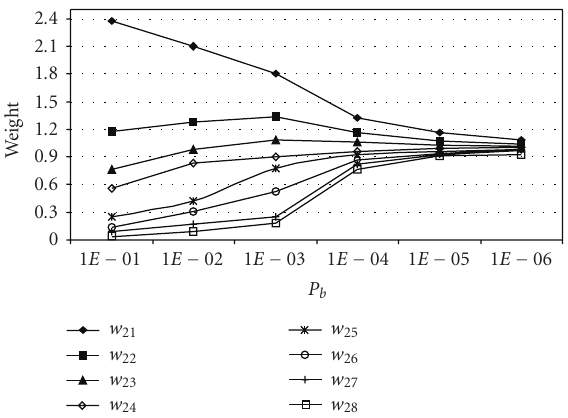
Figure 11: Weights values at varying channel conditions for the pa- rameter u 2 ( τ